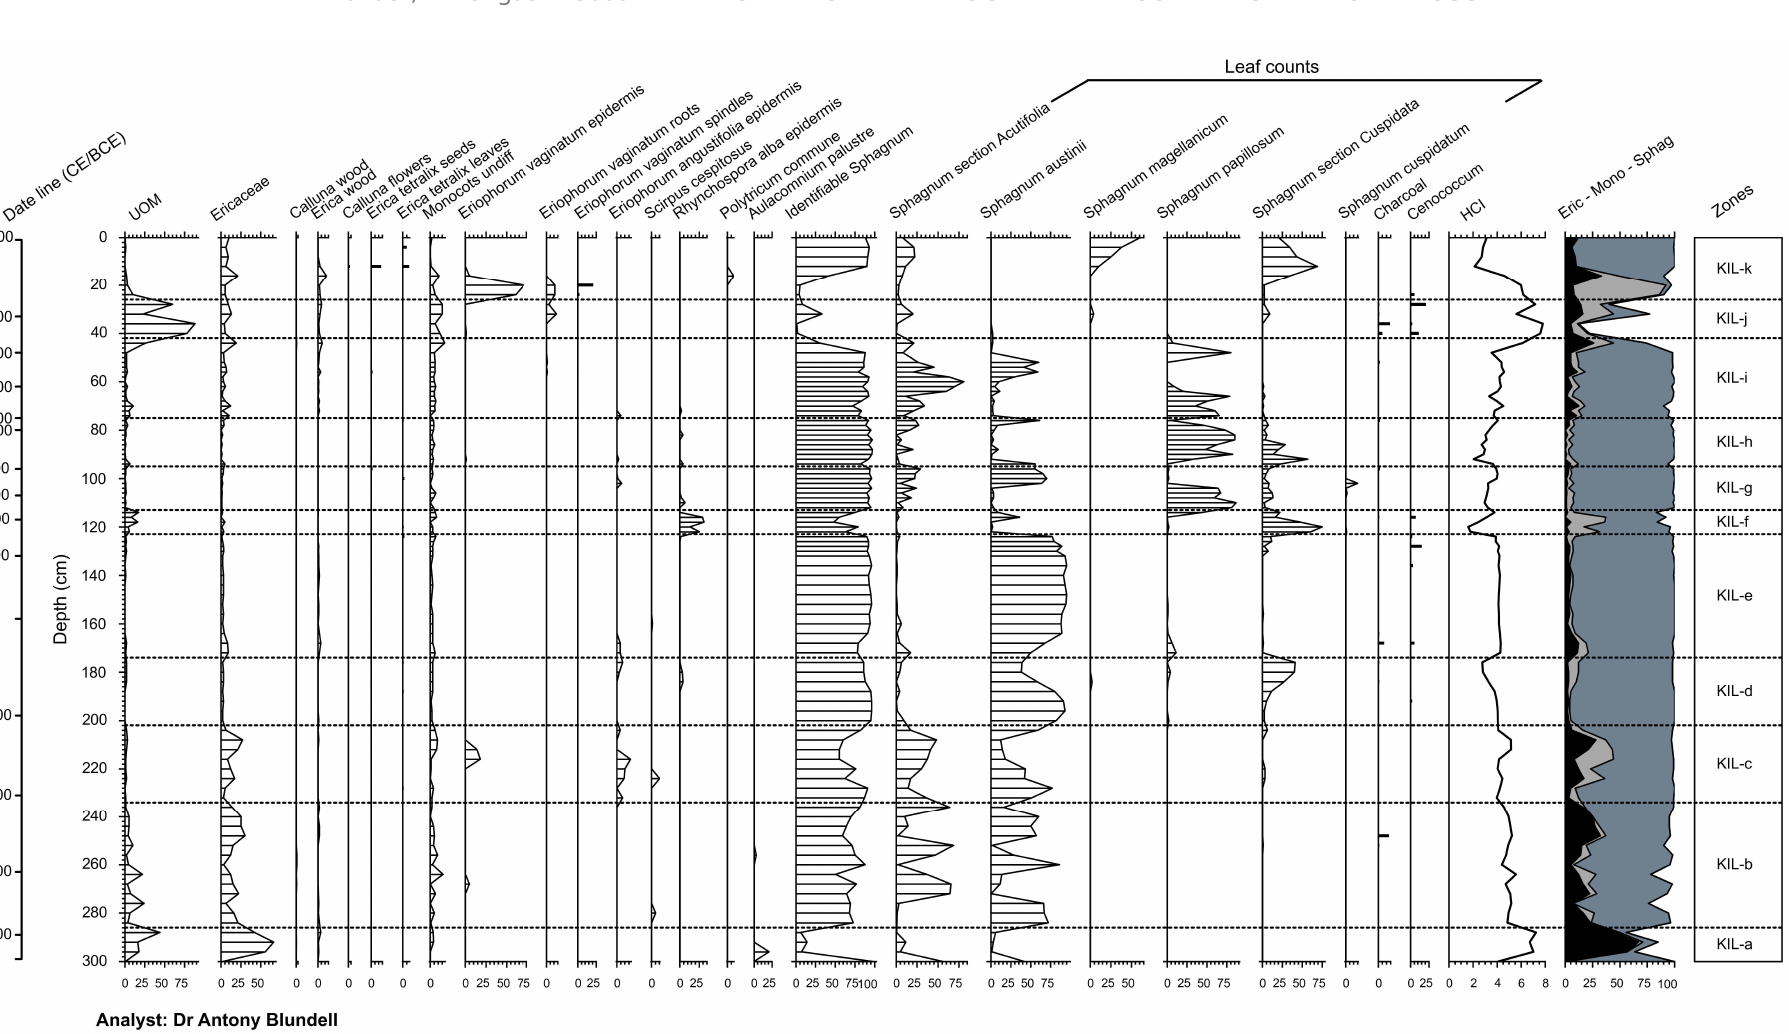
Figure 3. Macrofossil diagram for the Killorn Moss core. Peat components are derived from averaged quadrat counts under low-power magnification (×10). Leaf counts are a breakdown of the % identifiable Sphagnum and consist of proportions based on a random selection of leaves (100 per sample interval where possible) identified at high magnification (×400). Bar graphs are absolute counts. The Hydroclimatic Index (HCI) is also displayed, as is the percentage of the peat made up of Ericaceae (Eric), Monocotyledons (Mono) and Sphagnum